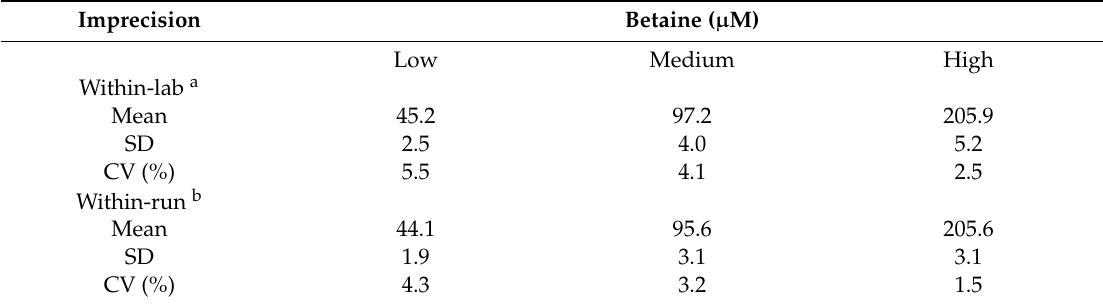
Table 1. Within-laboratory (inter-assay) and within-run (intra-assay) imprecision.